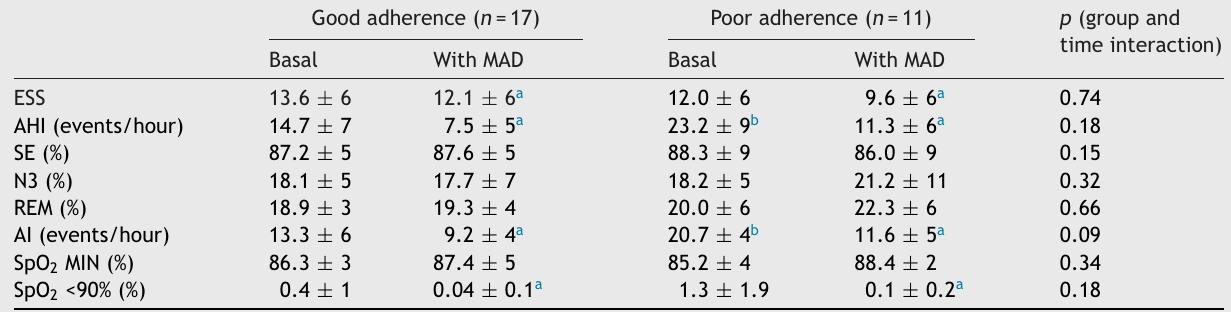
Comparison of the Epworth Sleepiness Scale and polysomnography parameters between patients with good and poor adherence to the mandibular advancement device (MAD) at baseline and after 120 days of MAD use. Good adherence ( n = 17) Poor adherence ( n = 11) p (group and With MAD Basal